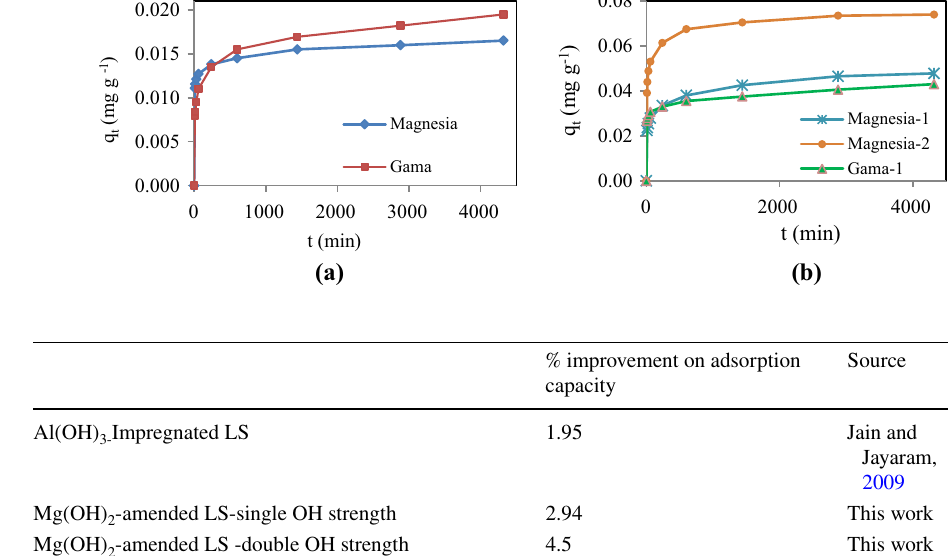
Fig. 5 Experimental F − adsorp- tion kinetics onto a native b amended LS subsamples